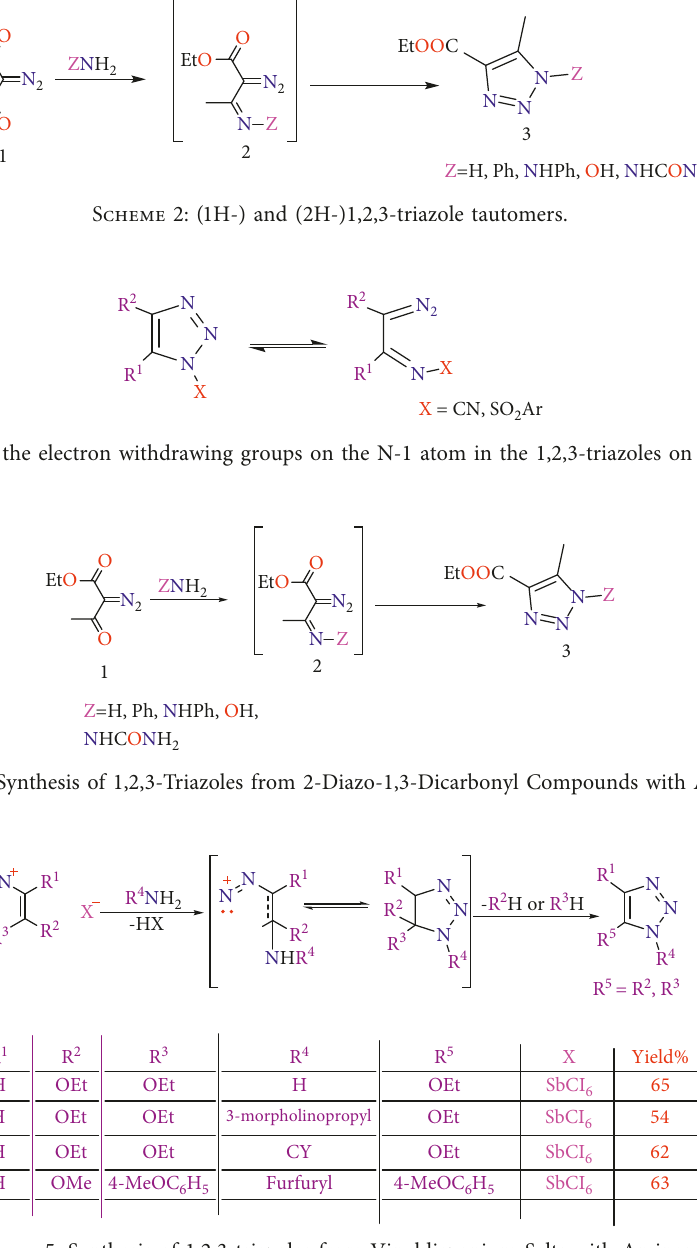
Scheme 5: Synthesis of 1,2,3-triazoles from Vinyldiazonium Salts with